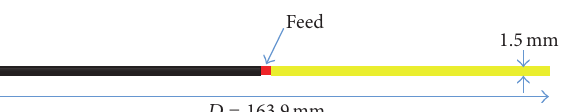
Figure 1: Structure of the half-wave dipole.